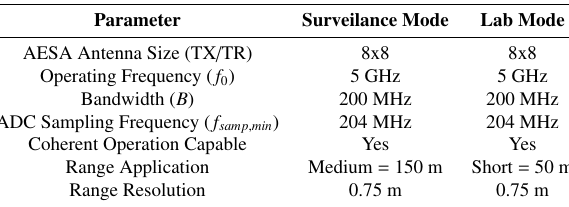
Table 2. MIMO Mode AESA Radar Minimum Performance